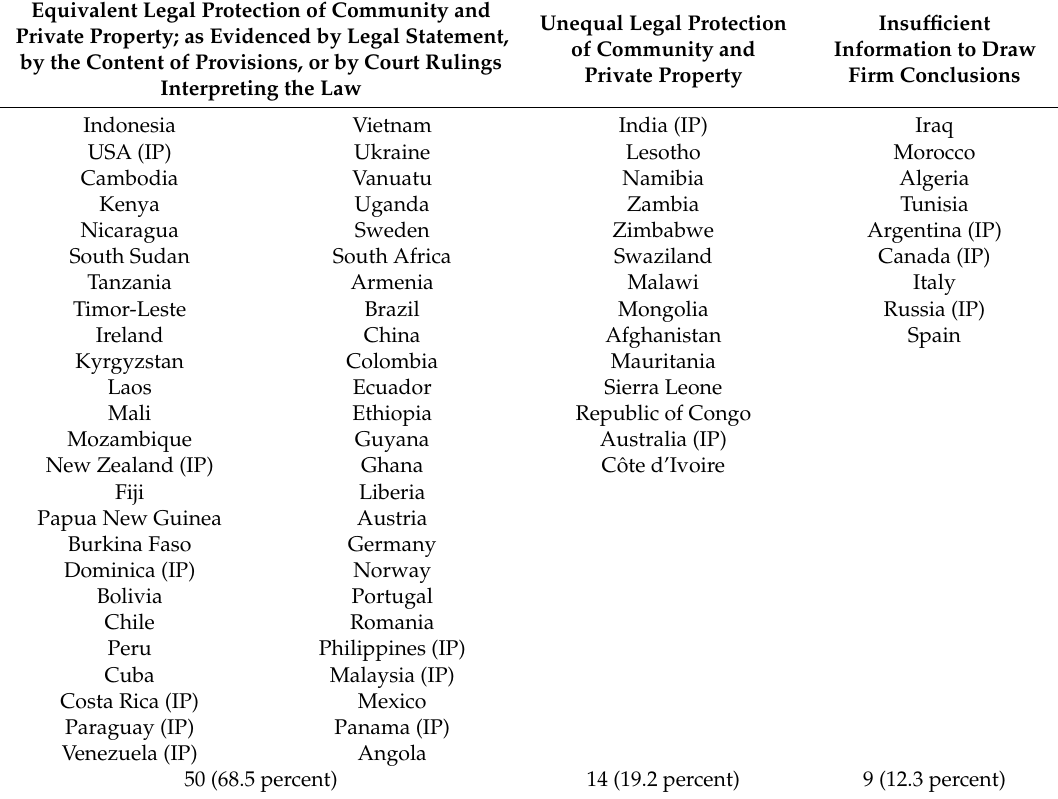
Table 7. Comparison of legal protection of private and community